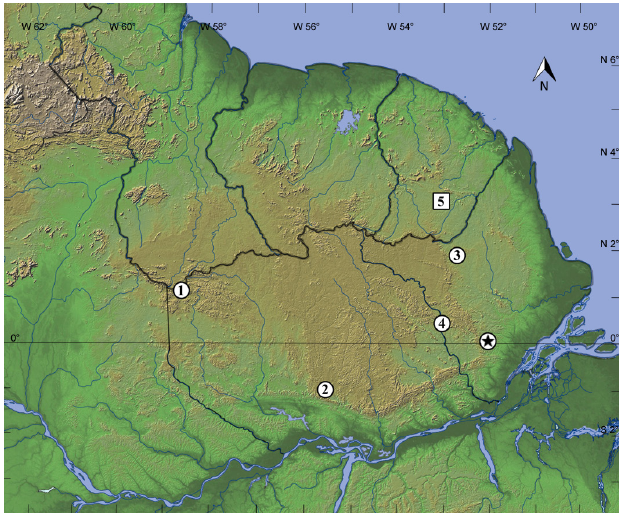
Amapasaurus tetradactylus Figure 1. Range extension of , a lizard endemic of the Guianan Shield. Star (Type locality): Brasil, Amapá, Igarapé Camaipi, affluent of upper Rio Maracá (Cunha 1970). Dots (Data from litterature): (1) Brasil, Pará, ESEC Grão-Pará North, Acarai Mountains et al (Avila-Pires et al. 2010); (2) Brasil, Pará, FLOTA Trombetas (Avila-Pires . 2010); (3) Brasil, Amapá, Tumucumaque Mountains National Park (Lima 2008); (4) Brasil, Amapá, Reserva de Desenvolvimento Sustentável Rio Iratapuru (Lima 2008). Square (This study): (5) French Guiana, Itoupé Mount, “Parc Amazonien de Guyane”. Mount Itoupé is entirely covered by forest, of which three main types can be seen: an irregular high forest with many large emerging trees (up to 60 m tall) on the west- facing slope; an irregular forest mixed with lianas on the east-facing side and an open forest on the summit (Sabatier and Molino, pers. com.). Below 500 m a.s.l., the lowland Burseraceae Xylopia forest, lying on well-drained slopes, is dominated by large trees from the family and by